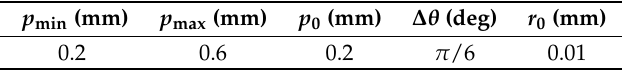
Table 3. Parameters for planning the initial spiral-polishing path.